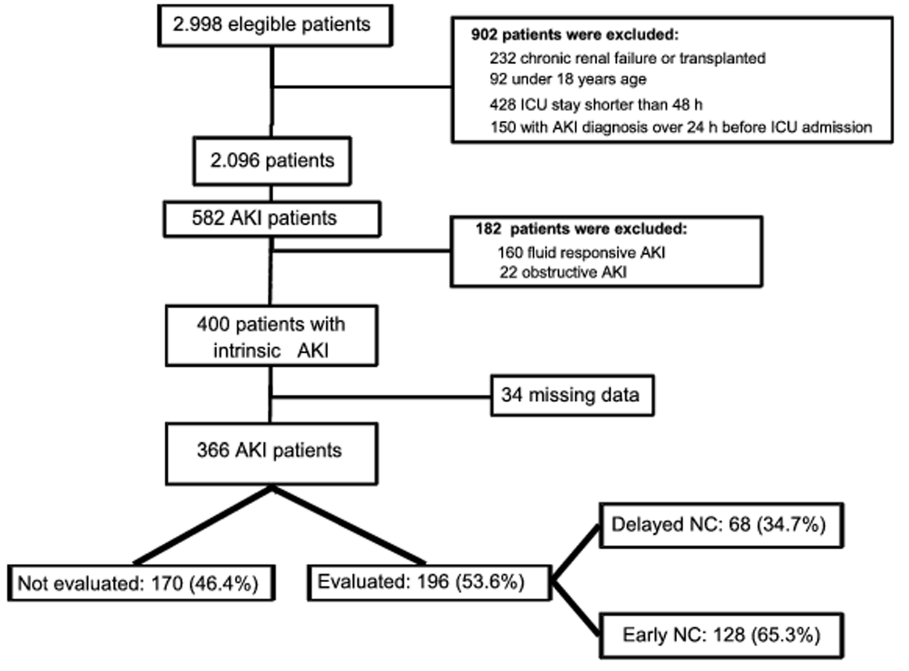
Figure 1. Flowchart of study population. ICU: intensive care unit; AKI: acute kidney injury; NC: nephrology consultation.